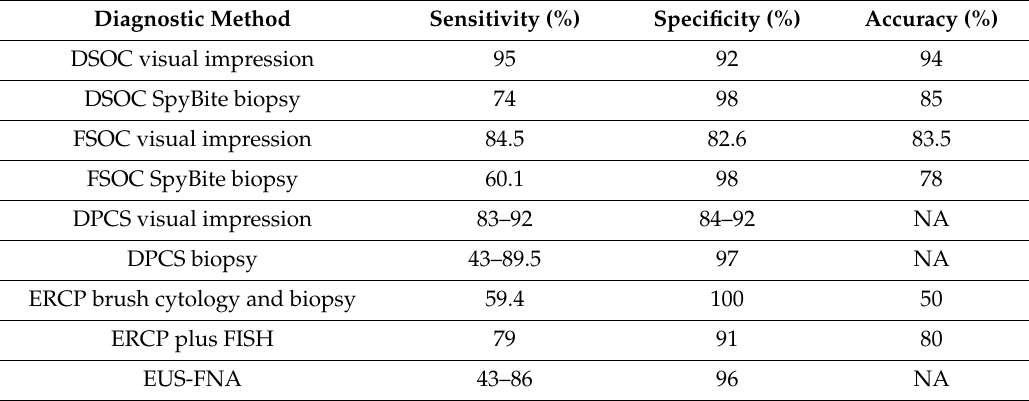
Table 2. The di ff erent diagnostic methods used to evaluate the biliary